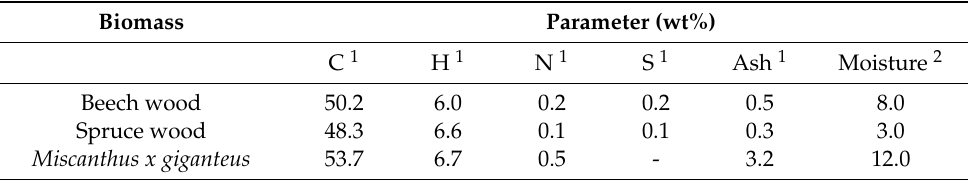
Table 4. Proximate and ultimate analysis of the